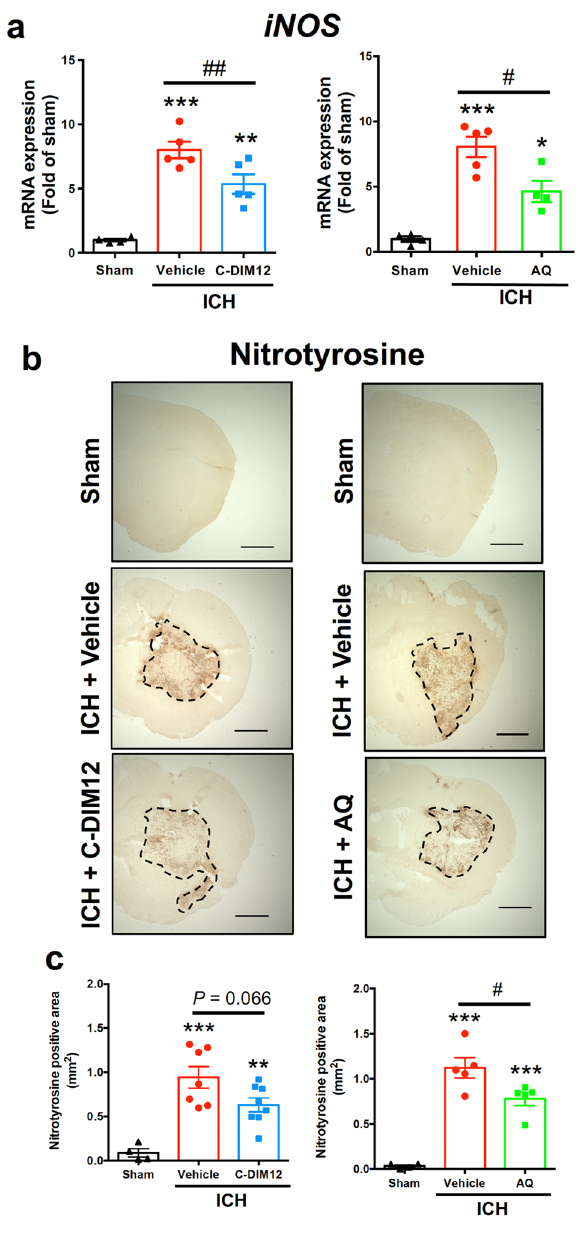
Figure 5. Effects of C-DIM12 and amodiaquine on iNOS expression and NO-related oxidative stress after ICH. C-DIM12 (50 mg/kg, p.o.), amodiaquine (AQ; 40 mg/kg, i.p.) or vehicle (p.o. or i.p.) was administered at 3, 27 and 51 h after ICH induction. ( a ) Expression level of iNOS mRNA was quantified at 6 h after ICH. Number of mice examined was 4 in sham group, 5 in ICH + vehicle group, 5 in ICH + C-DIM12 group and 4 in ICH + AQ group, respectively. ( b ) Representative images of nitrotyrosine immunohistochemistry at 72 h after ICH. Scale bars = 1 mm. ( c ) Quantitative results of nitrotyrosine-positive area in the ipsilateral hemisphere. Number of mice examined was 4 in sham group, 7 in ICH + vehicle group (for C-DIM12), 8 in ICH + C-DIM12 group, 5 in ICH + vehicle group (for AQ) and 5 in ICH + AQ group, respectively. * P < 0.05, ** P < 0.01, *** P < 0.001 versus sham group, # P < 0.05, ## P < 0.01 (ANOVA results: for left panel of a , F 2,11 = 30.71, P < 0.001; for right panel of a , F 2,10 = 26.64, P < 0.001; for left panel of c , F 2,16 = 15.00, P < 0.001; for right panel of c , F 2,11 = 41.10, P <